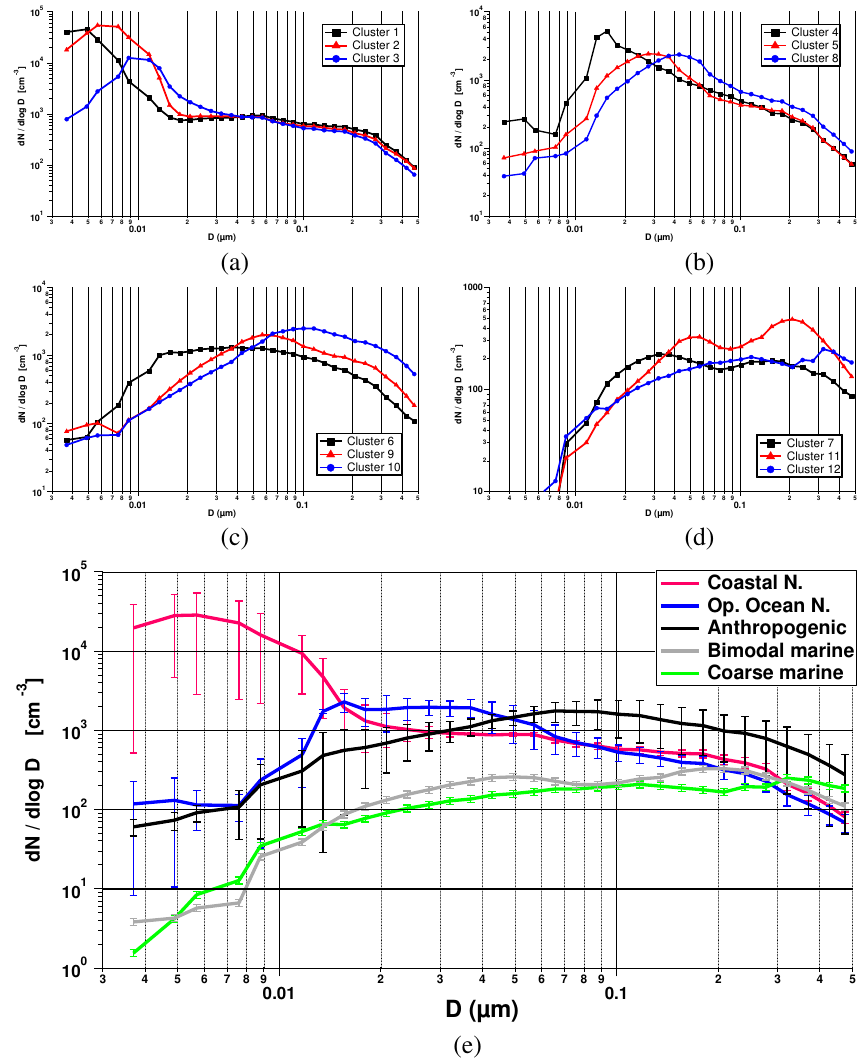
Figure 3: (a) cluster 1, 2 and 3 (coastal nucleation) (b) cluster 4, 5 and 8 (open ocean nucleation) (c) cluster 6, 9 and 10 (anthropogenic) and (d) cluster 7, 11 and 12 (background clean marine). Please note difference in log scale for (a) 10 5 (b) and (c) 10 4 and (d) 10 3 . Figure 4 (e) shows the average size distribution for each of the four groups (error bars are one sigma standard deviation). Aerosol category background clean marine is presented as bimodal marine (cluster 7 and 11) and coarse marine (cluster 12)